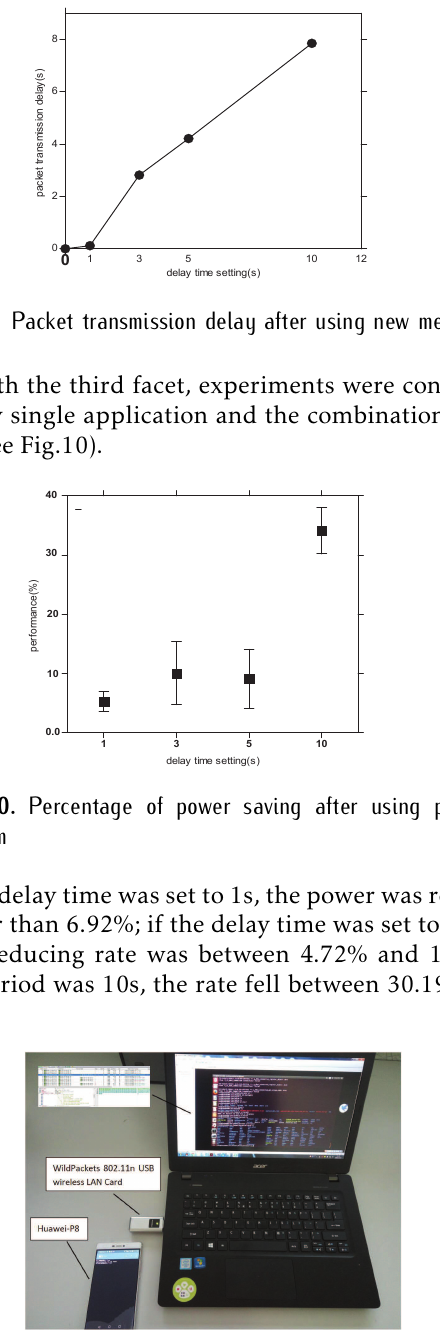
Figure 11. Picture of the experimental